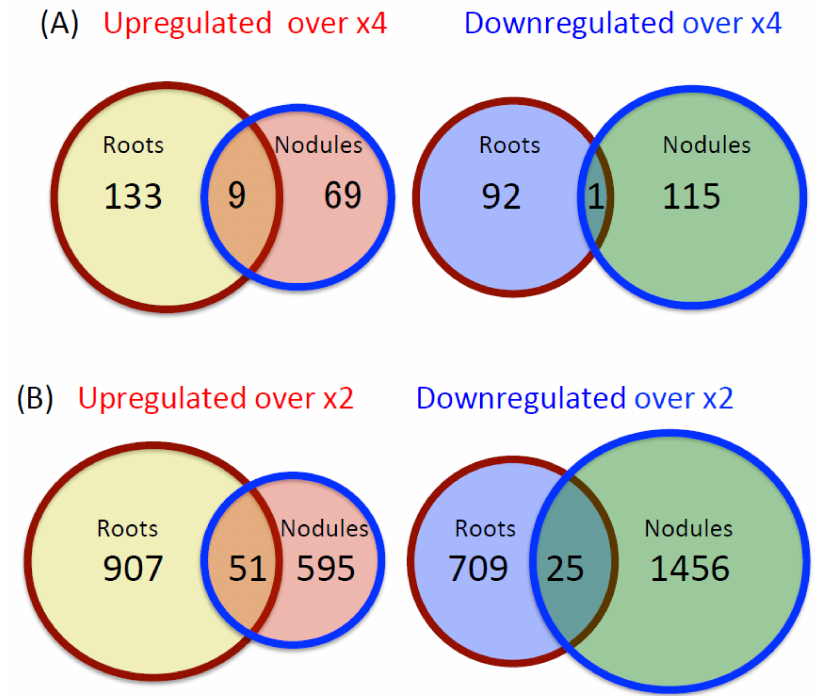
Figure 1. Numbers of probesets in soybean roots and nodules upregulated or downregulated genes by more than × 4 or × 2 following the addition of 5 mM of nitrate to the medium for 24 h, at the level of p < 0.05 (Student’s t -test). Data were obtained from three independent biological replications. ( A ) Numbers of probesets in the roots and nodules upregulated or downregulated genes by more than fourfold. ( B ) Numbers of probesets in the roots and nodules upregulated or downregulated genes by more than